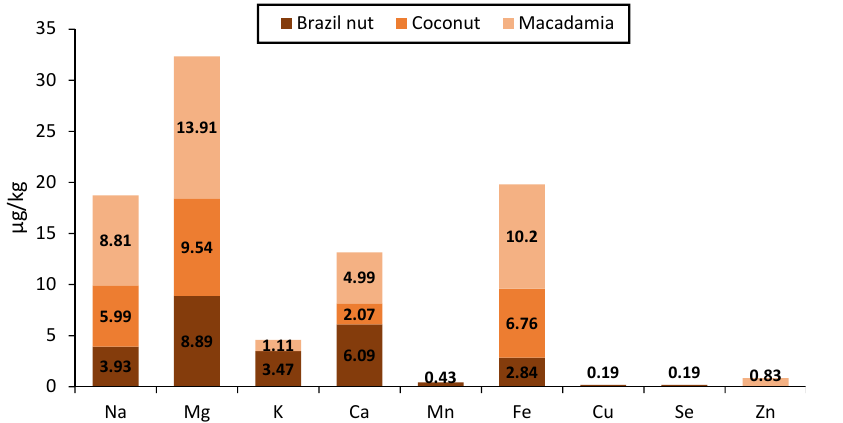
Figure 8. Comparison of mineral content of cold-pressed macadamia nut oil with cold-pressed oil from selected tree nuts. Adapted from Cicero et al. [37].